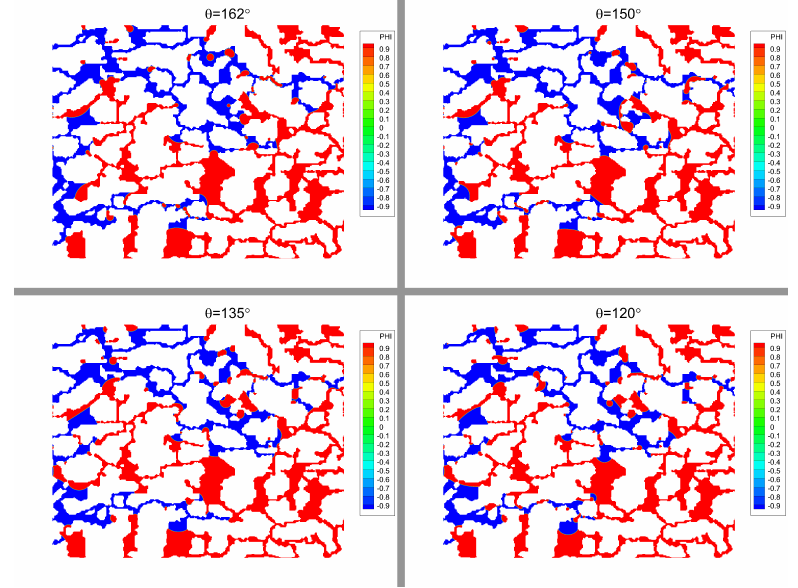
Figure 9. Fluid distributions at breakthrough for a wetting fluid invading a porous medium initially saturated with a non-wetting fluid. The wetting fluid (indicated in blue) is injected from the left side and the values of the contact angle are 162 ◦ , 150 ◦ , 135 ◦ , and 120 ◦ ,